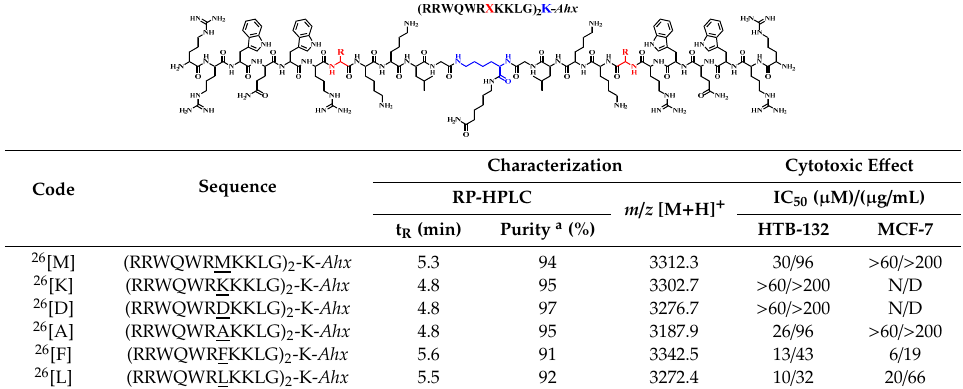
Table 1. Dimeric peptides derived from Bovine Lactoferricin (20-30). General structure, characterization and cytotoxic effect against breast cancer cell lines. The peptide chain amino acid at position 26 is shown in red.